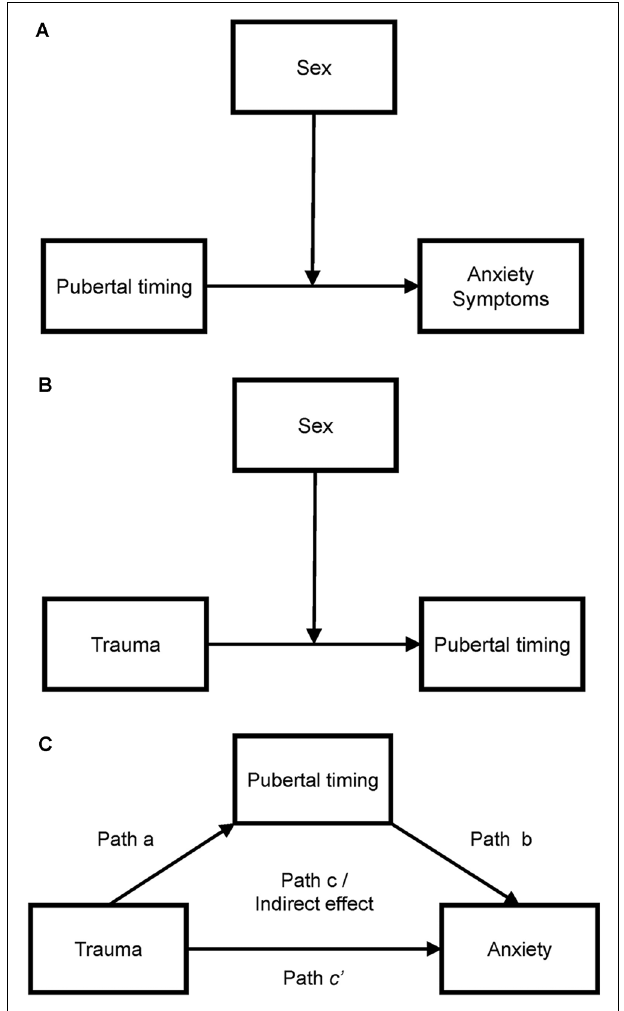
FIGURE 2 | Moderation model used to test for sex differences in the association between trauma exposure and pubertal timing (Panel A ), the association between pubertal timing and anxiety symptoms (Panel B ), and statistical mediation model for the associations between trauma, pubertal timing, and anxiety symptoms in girls (Panel C